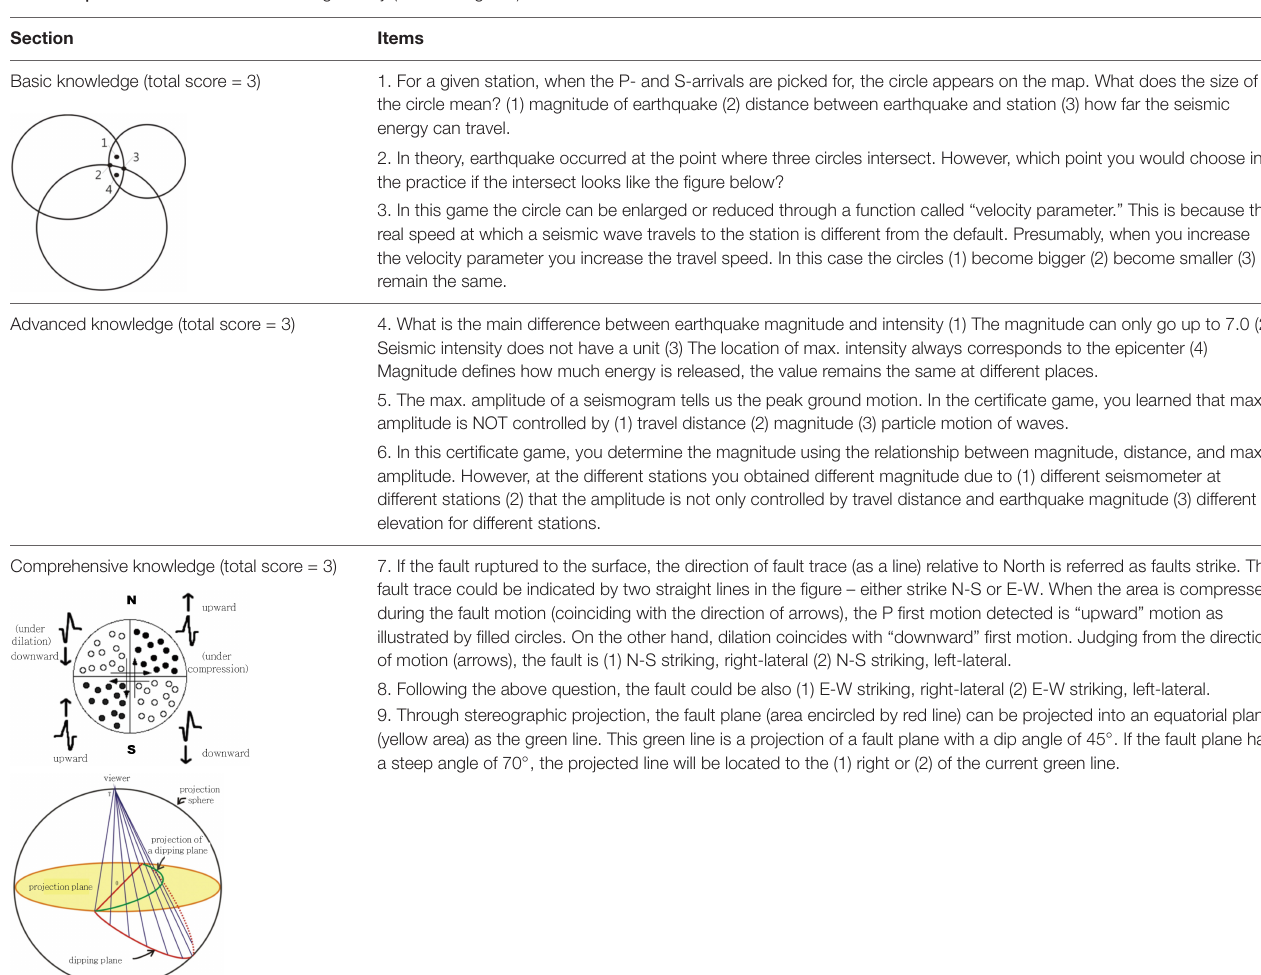
TABLE 2 | Items in each section of training activity (certificate game). Section